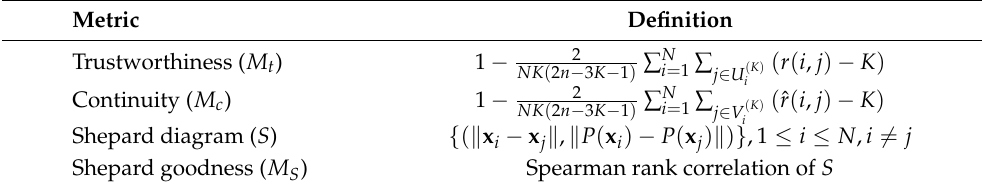
Table 3. Projection quality metrics used in our quantitative evaluation (Section